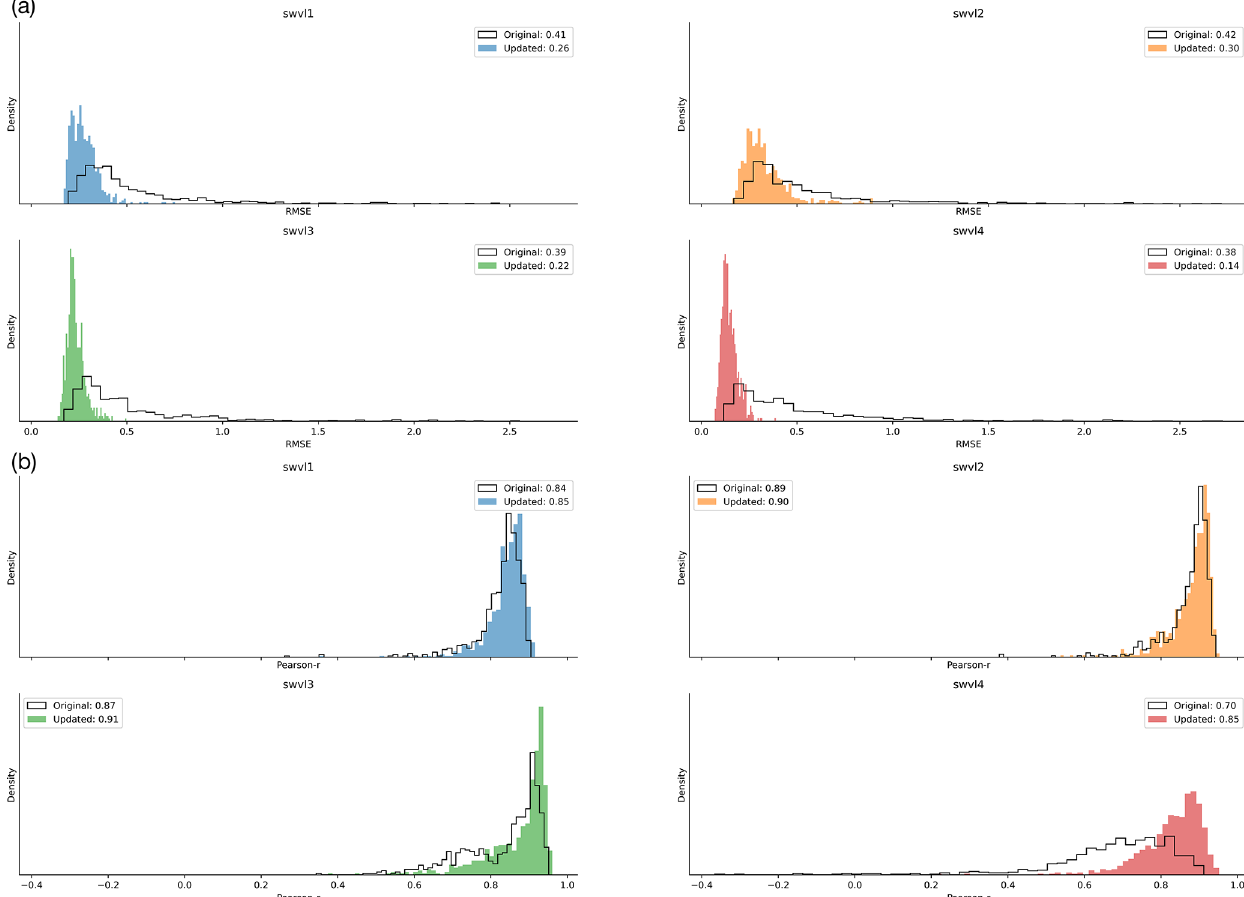
Figure C3. Histograms showing the distribution of catchment error metrics. The original linear regression model is shown as a solid black line. The coloured histograms correspond to the updated model with augmented inputs (using one-hot encoded data) for each soil water level. Subplot (a) contains histograms showing the root mean squared error (RMSE) metric is much improved when modelling with the one-hot encoded data. Subplot (b) contains histograms showing the correlation metric, showing that the dynamics are well modelled by the original linear regression, since the different biases do not influence the correlation